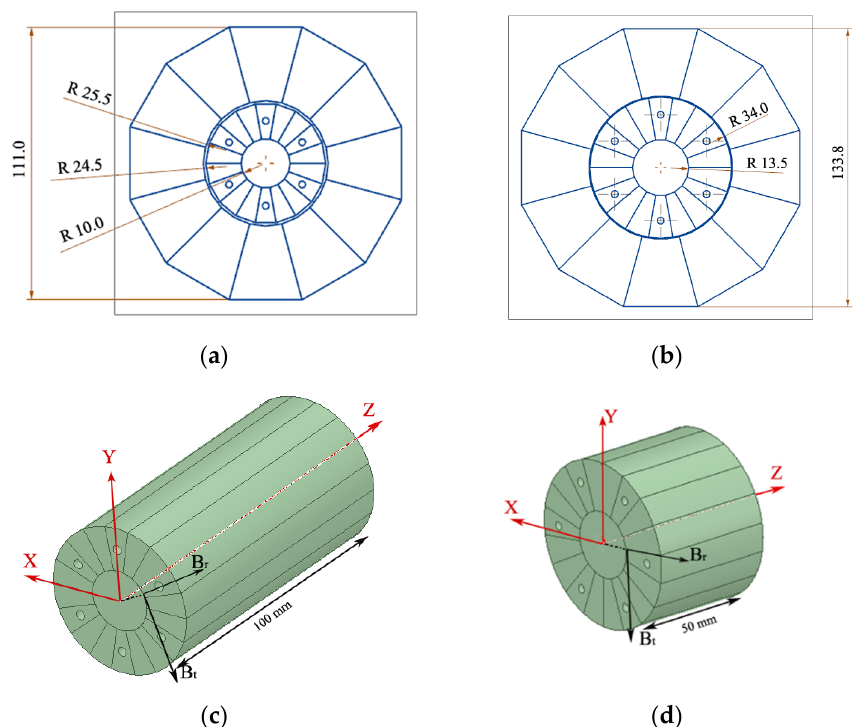
Figure 6. Geometry of the models with bore diameters of 20 mm and 27 mm: ( a ) cutaway of model 1; ( b ) cutaway of model 2; ( c ) outline of the inner circle of model 1; ( d ) outline of the inner circle of model 2.